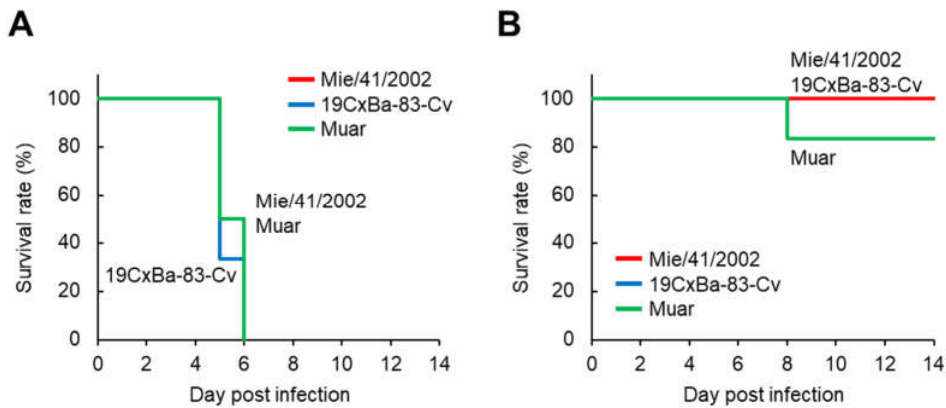
Figure 4. Murine neurovirulence of the GI, GIV, and GV JEV strains. Survival curve of mice inoculated intracerebrally with 3 × 10 3 PFU ( A ) and 3 × 10 2 PFU ( B ) of Mie/41/2002 ( n = 6), 19CxBa-83-Cv ( n = 6), or Muar ( n = 6).